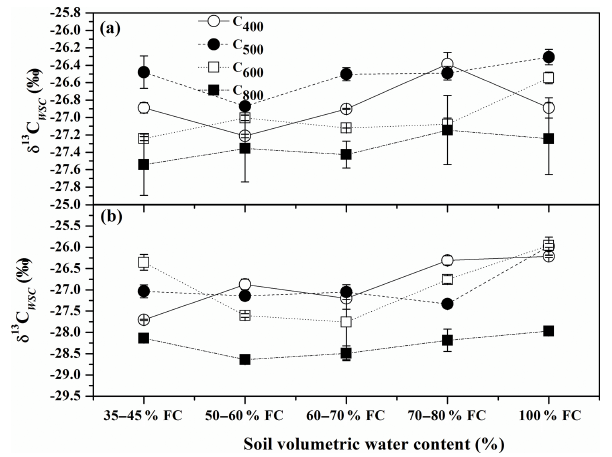
Figure 4. Instantaneous water use efficiency through gas-exchange measurements (WUE ge ) for leaves from P. orientalis (a) and Q. variabilis (b) for four CO 2 concentration × five soil volumetric water content treatments. Means ± SDs, n = 32.